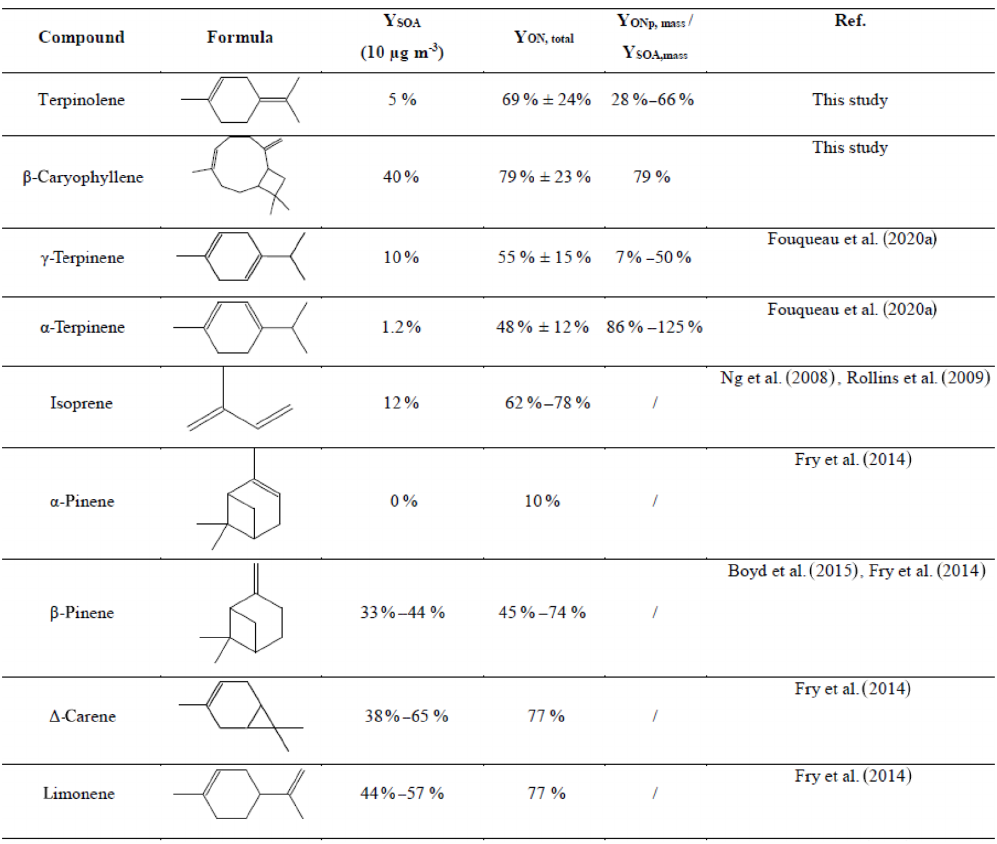
Table 5. Mean SOA and organic nitrate yields obtained in this study for terpinolene and β -caryophyllene and for other terpenes in the